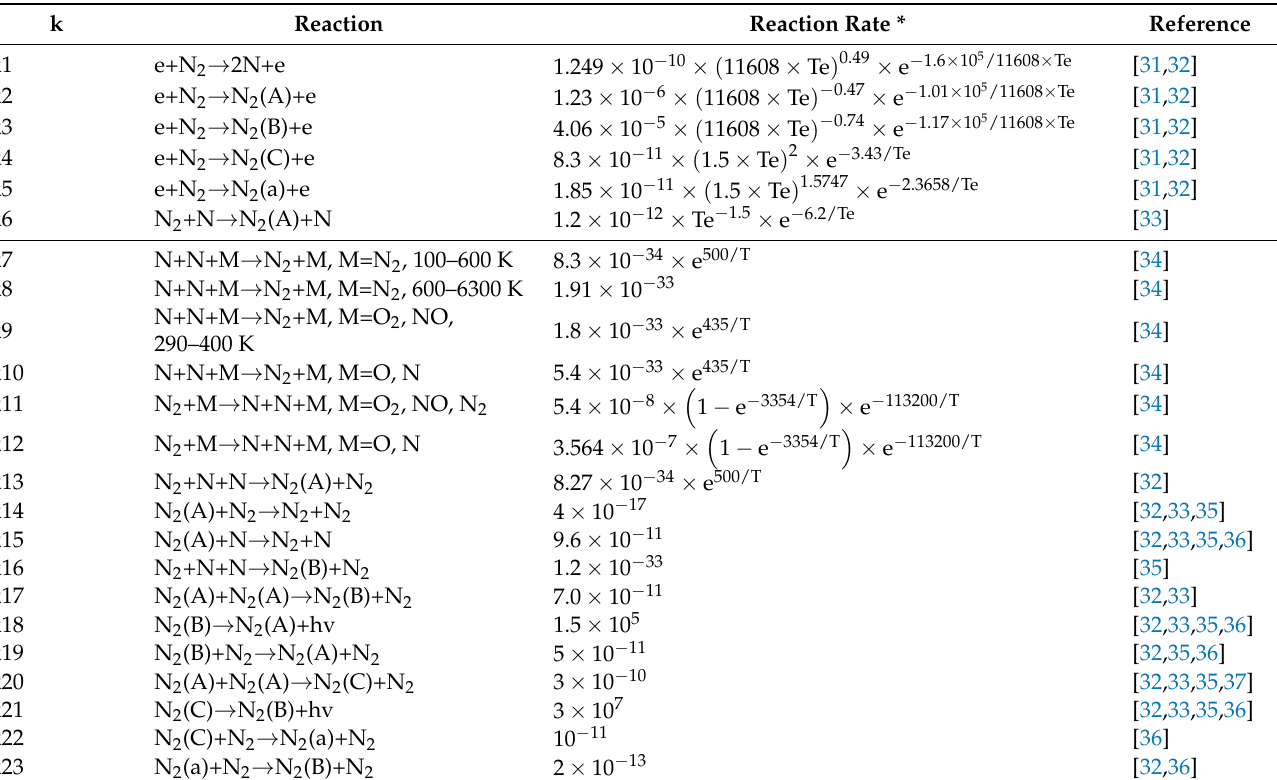
Table 3. Reaction rates considered in this computing